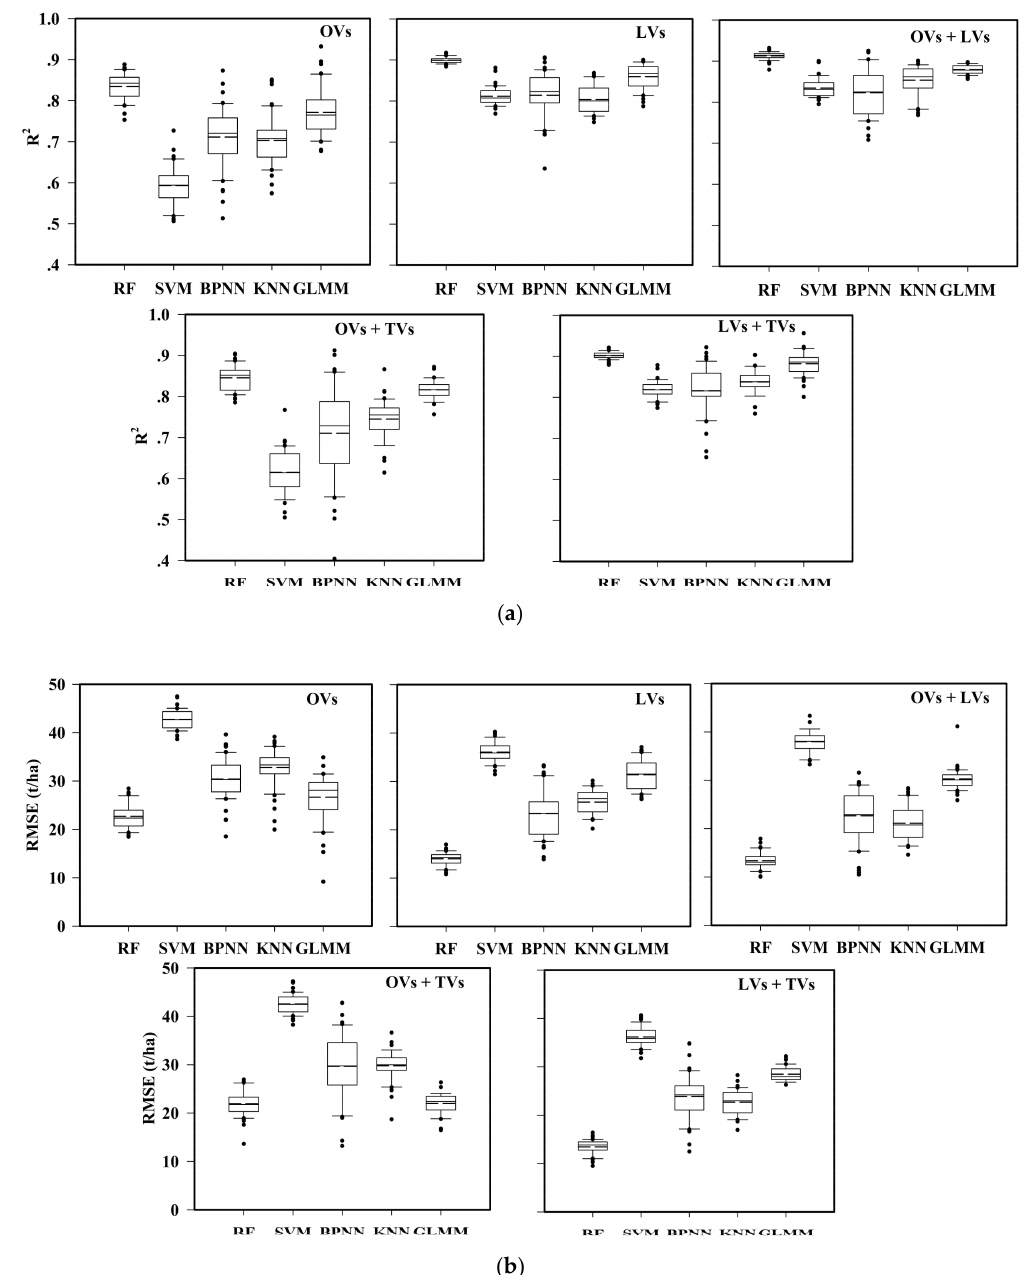
Figure 2. The boxplots illustrate model accuracy results using different input datasets and prediction methods: The distribution of the mean R 2 ( a ) and the mean RMSE ( b ) from the 50 bootstrapped models obtained using the five-fold-cross-validation for each prediction method. The black dotted lines represent the mean value. RF, Random Forest; SVM, Support Vector Machines; BPNN, Back Propagation Neural Networks; KNN, K-Nearest Neighbor; GLMM, Generalized Linear Mixed Model; OVs, optical variables; LVs, LiDAR variables; OVs + LVs, the combination of optical and LiDAR variables, OVs + TVs, the combination of optical and terrain variables; LVs + TVs, the combination of LiDAR and terrain